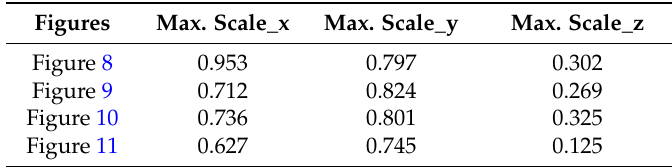
Table 1. Quantitative results of the three operators.